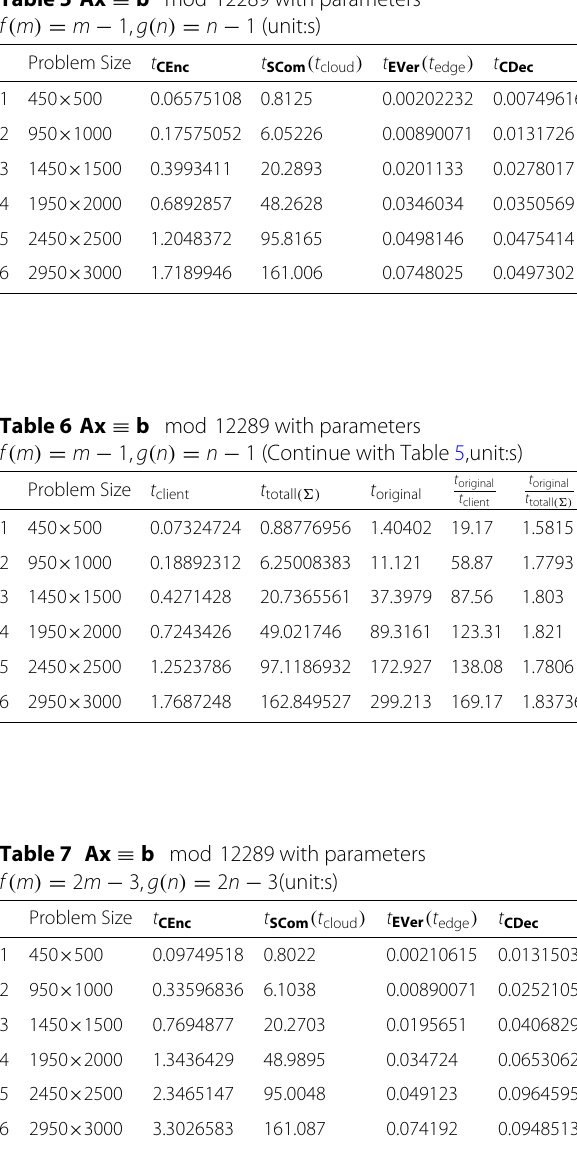
Table 5 Ax ≡ b mod 12289 with parameters